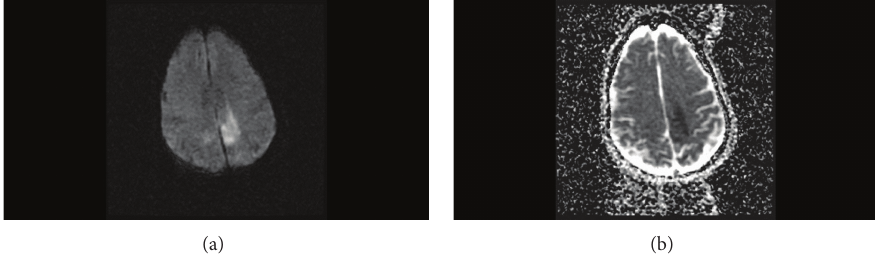
Figure 4: Axial diffusion-weighted (a) and ADC (b) MR images of the brain on postoperative day 5 revealing focal restricted diffusion and low ADC signal in the left posterior frontoparietal area consistent with acute infarction.